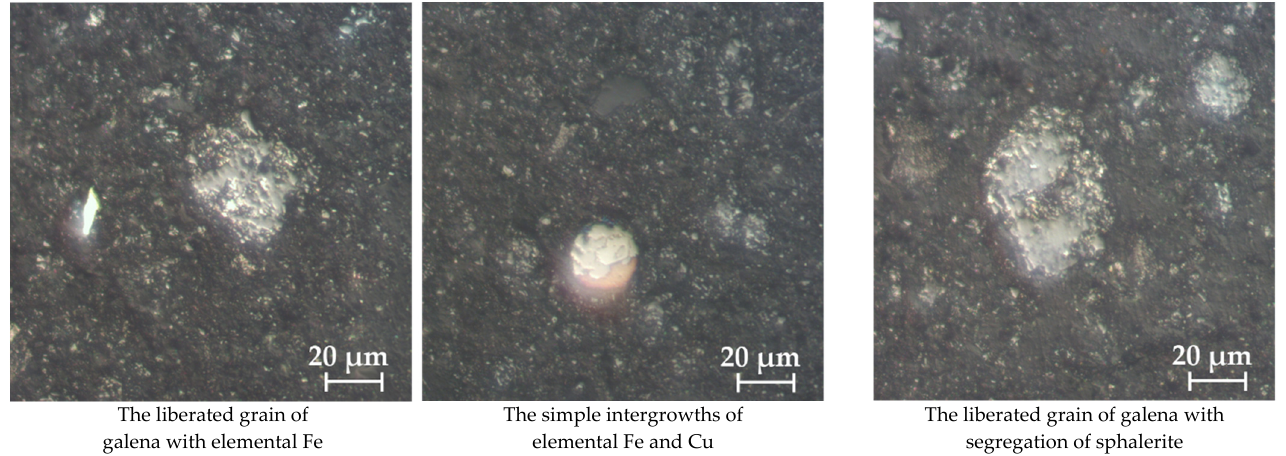
Figure 18. Optical microscopy of sulfidized jarosite-PbAg sludge with the addition of sulfur and carbon. The optical microscopy study of sulfidized jarosite-PbAg sludge, with the addition of sulfur and carbon for magnetic separation (sample no 8-89/9_S/2_C) is given in Figure 19, showing mineral grains of galena, sphalerite, elemental iron and copper, spinel phases, hematite, magnetite, and graphite. The most common mineral is galena, occurring mostly in liberated grains, in the range from 10 to more than 250 µm. Sphalerite is rare, appearing in the form of liberated grains, inclusions, and simple intergrowths with galena. Elemental copper is also rare occurring in the form of simple intergrowths with elemental iron.